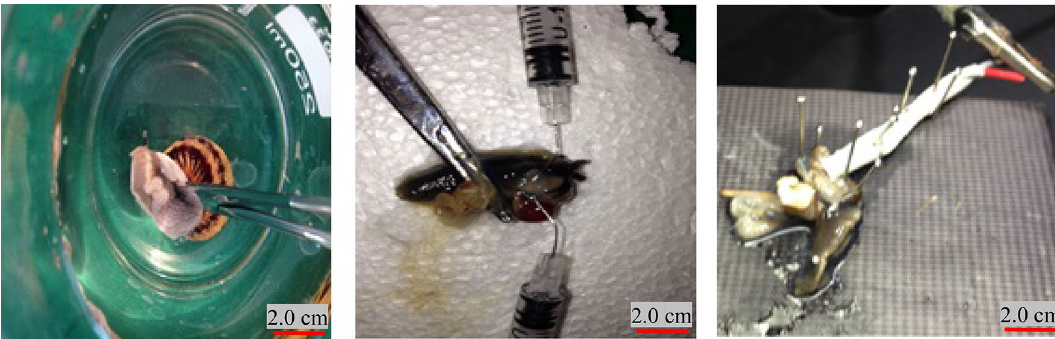
Figure 4. Photographic images of the snail soma at different stages of the in-vitro blind